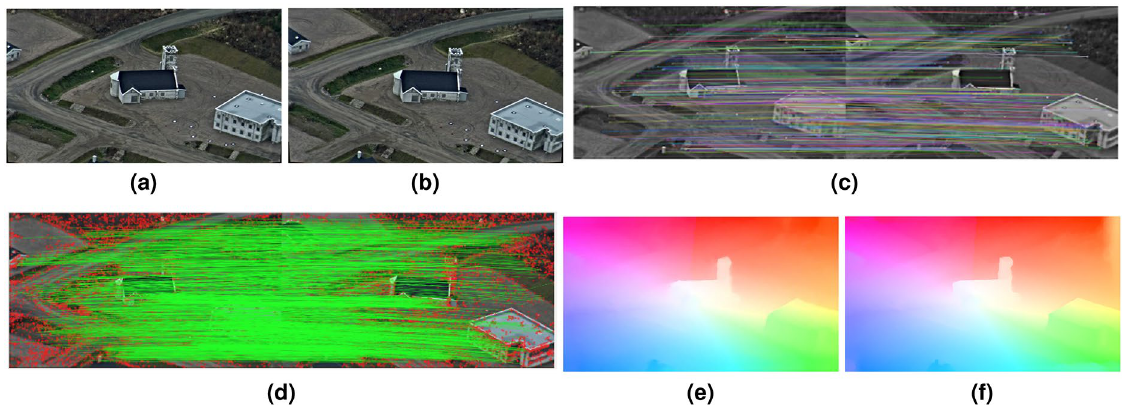
Figure 8. Density of matches. The first row ( a,b ) shows an example of the input image frames, © His Majesty the King in Right of Canada, as represented by the Minister of National Defence, 2022., ( c ) shows SIFT 41 matches, ( d ) shows RootSIFT 28 matches, ( e,f ) shows EpicFlow 10 and HybridFlow results.